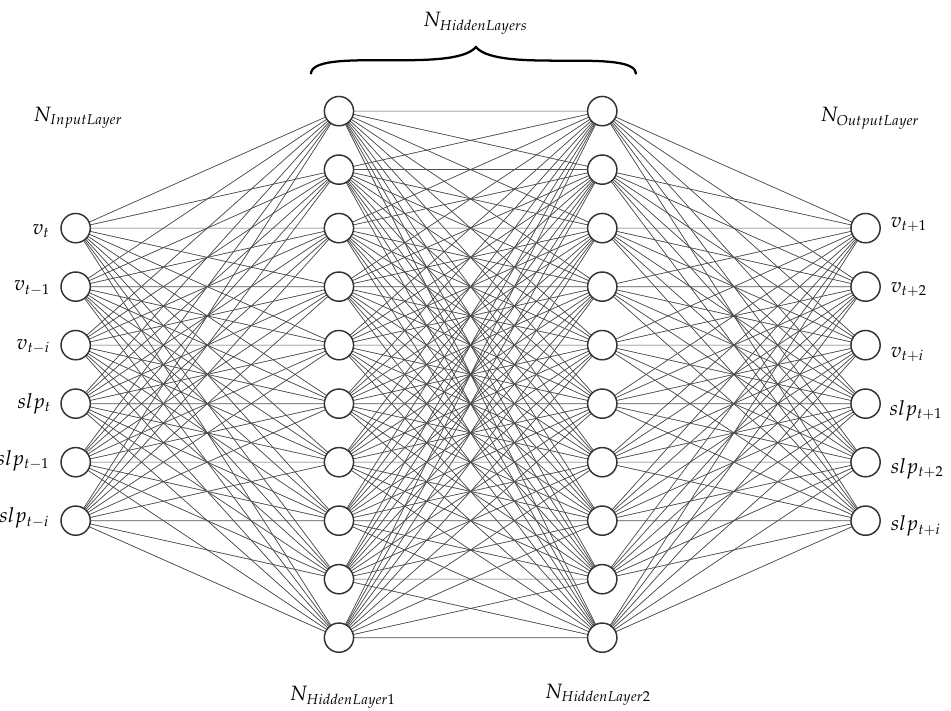
Figure 6. Feedforward Neural Network used for